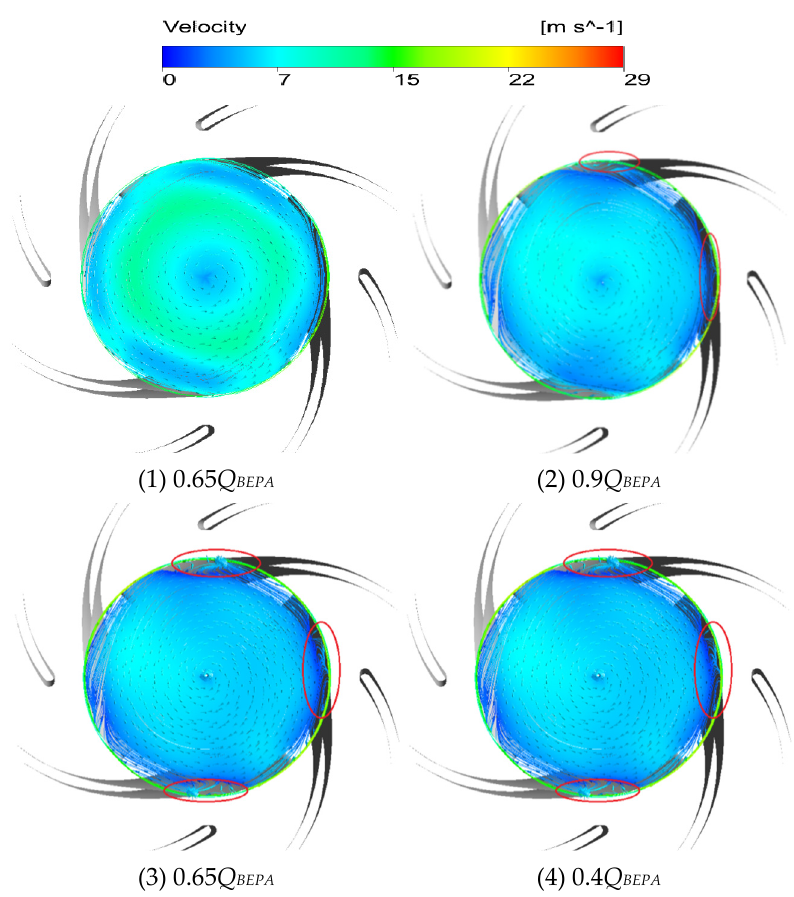
Figure 9. The velocity distribution in the impeller C at different flow rates.